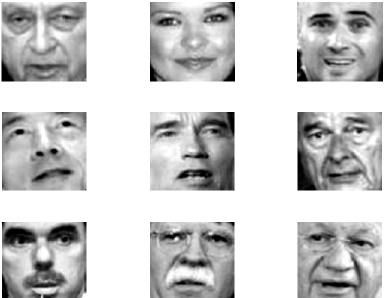
Figure 13. Sample of greyscale facial images from Face Recognition Technology (FERET) database [26] used as original biometrics.